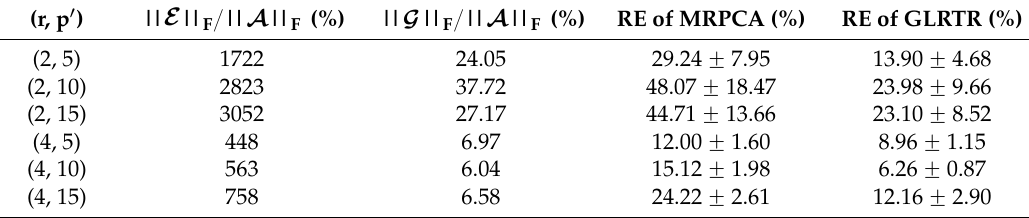
Table 2. Comparison of experimental results on 20 ˆ 20 ˆ 20 ˆ 20